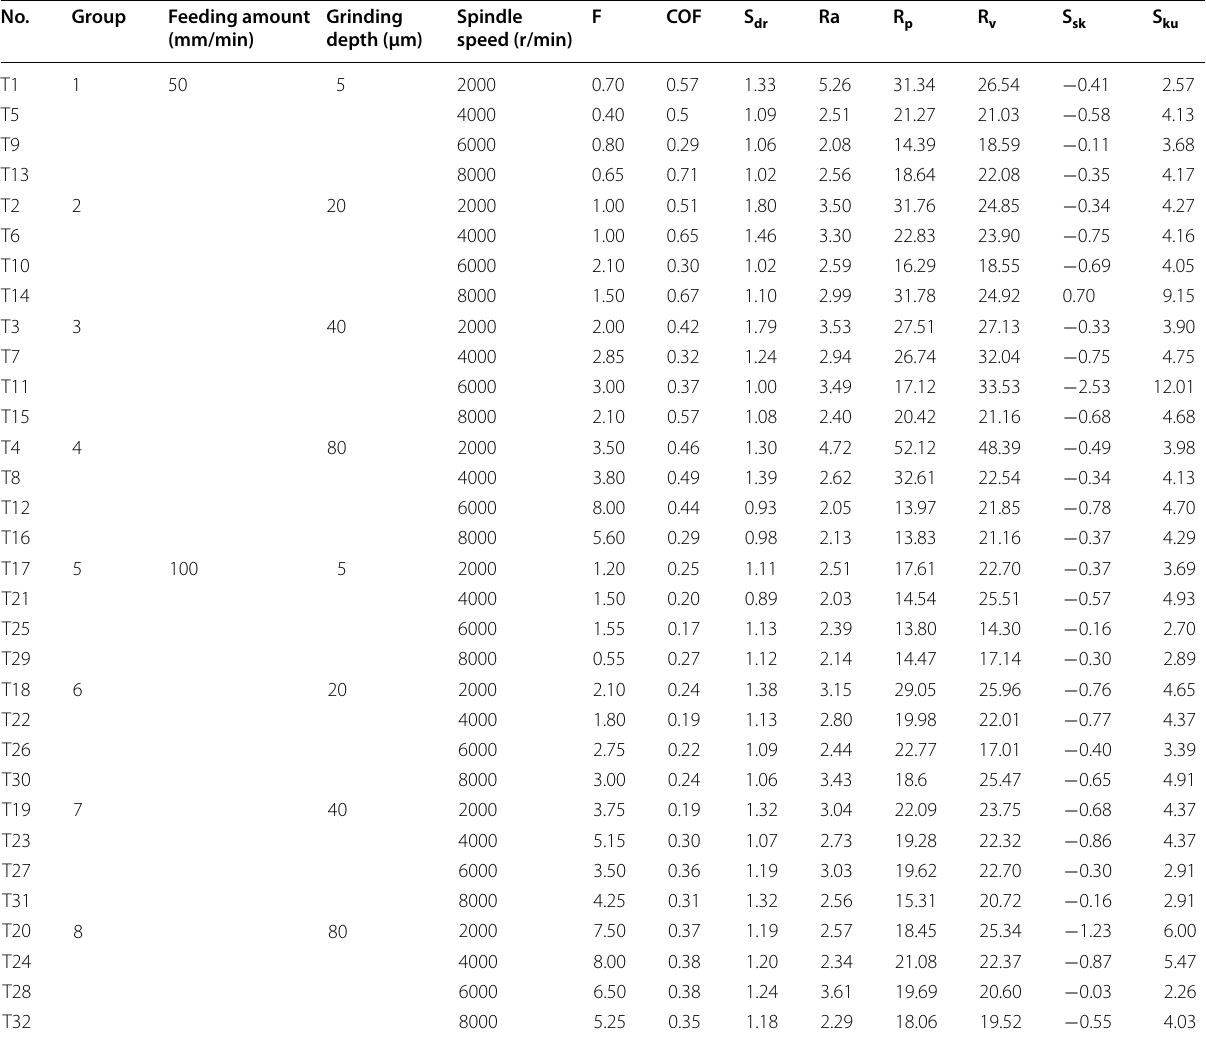
Table 3 Parameters of surface quality No. Group Feeding amount